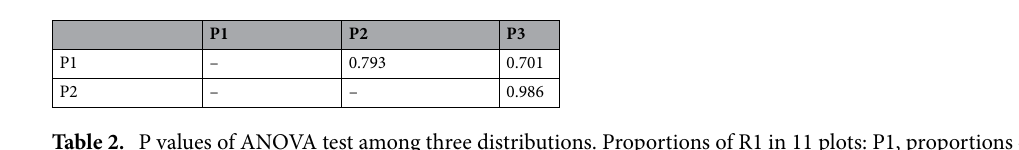
Table 2. P values of ANOVA test among three distributions. Proportions of R1 in 11 plots: P1, proportions of reference trees/structural units based on the frequency of numbers; P2, proportions of reference trees based on basal area; P3, proportions of structural units based on basal